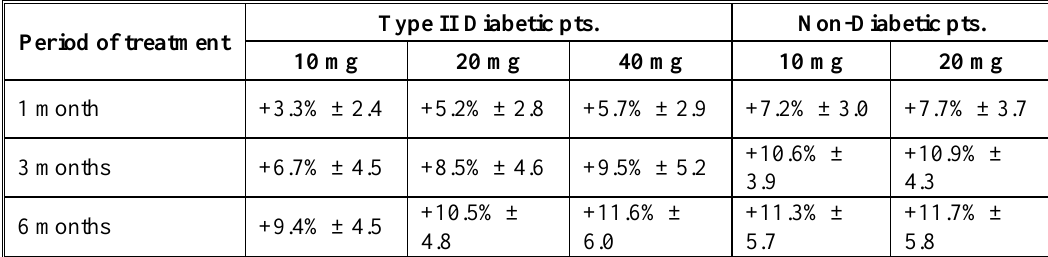
Table 3 :Percentage of serum HDL-Cholesterol elevation after treatment with Atorvastatin * Type II Diabetic pts. Non-Diabetic pts. Period of treatment